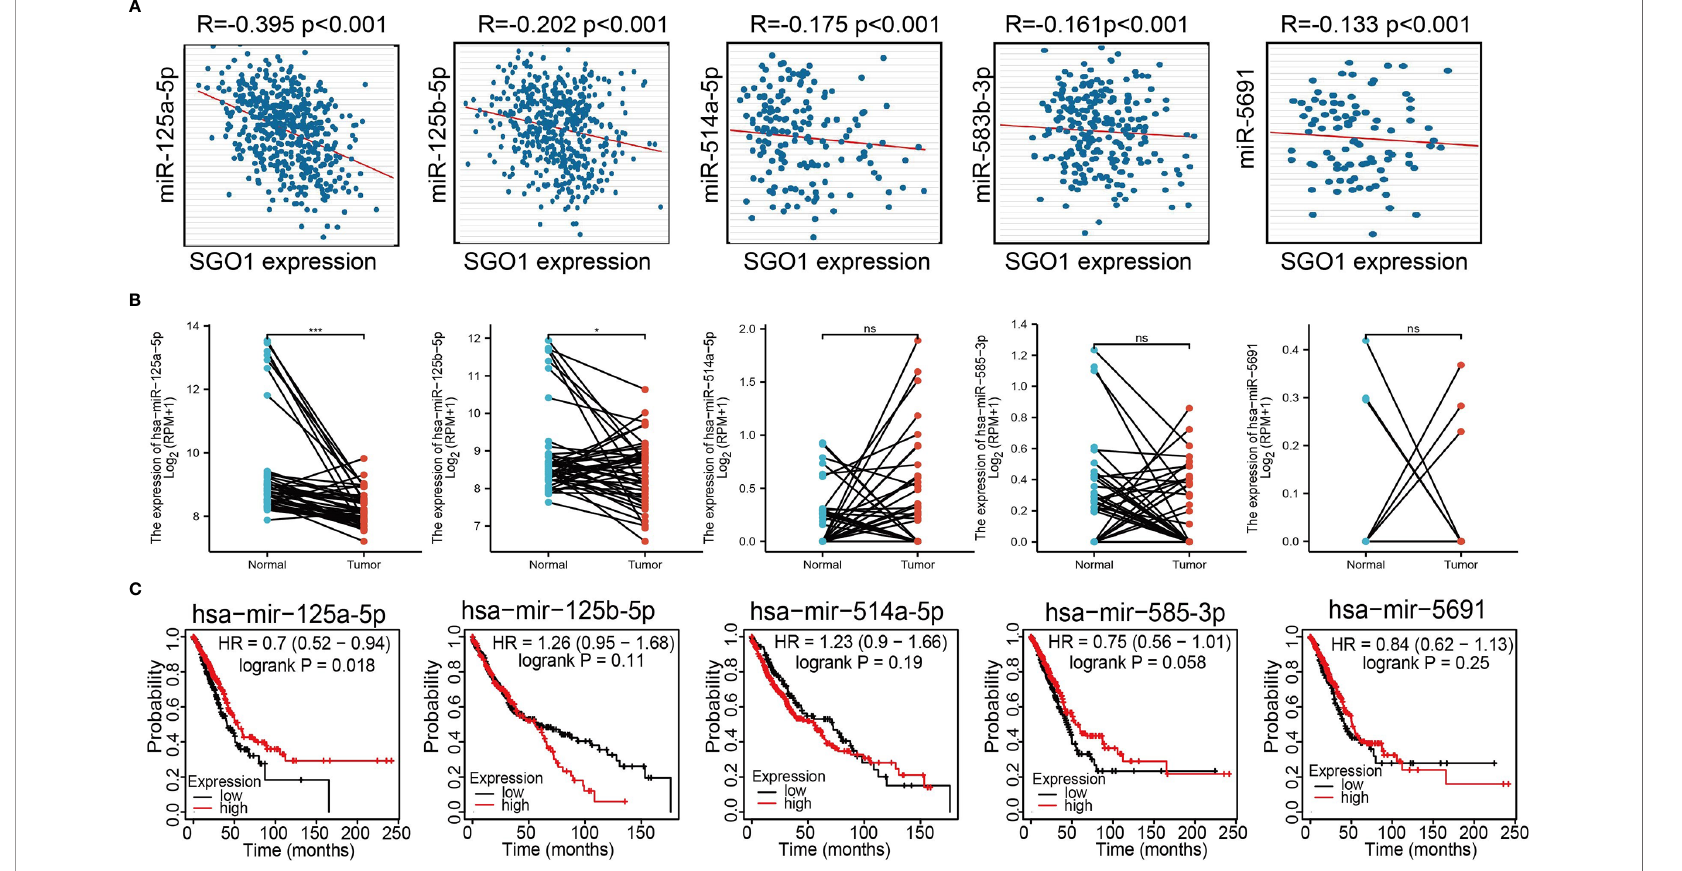
FIGURE 9 | Analysis of the potential miRNAs of SGO1. (A) Correlations between SGO1 expression and miRNAs (miR-125a-5p, miR-125b-5p, miR-514a-5p, miR-585-3p, and miR-5691) in LUAD. (B, C) The expression level and prognosis of miRNAs (miR-125a-5p, miR-125b-5p, miR-514a-5p, miR-585-3p, and miR-5691) in LUAD .NS: P<0.05, *P<0.05, and